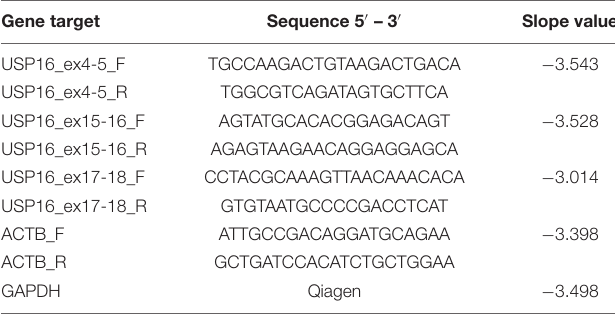
TABLE 1 | qPCR primers and efficiencies for USP16 expression analysis. Gene